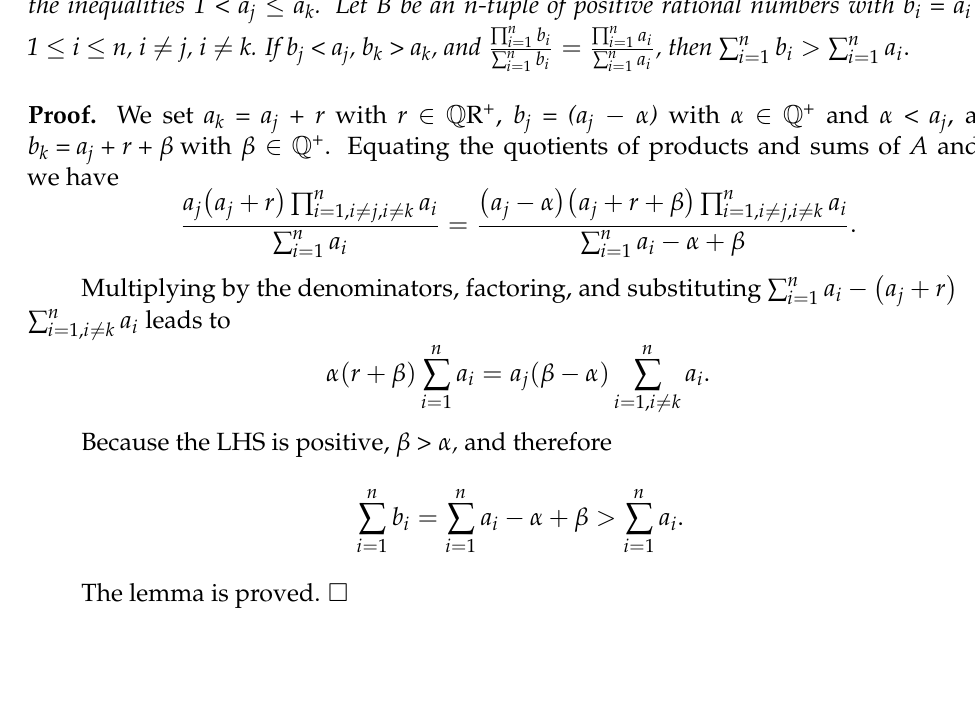
Table 1. Sum of solution terms of ∏ n